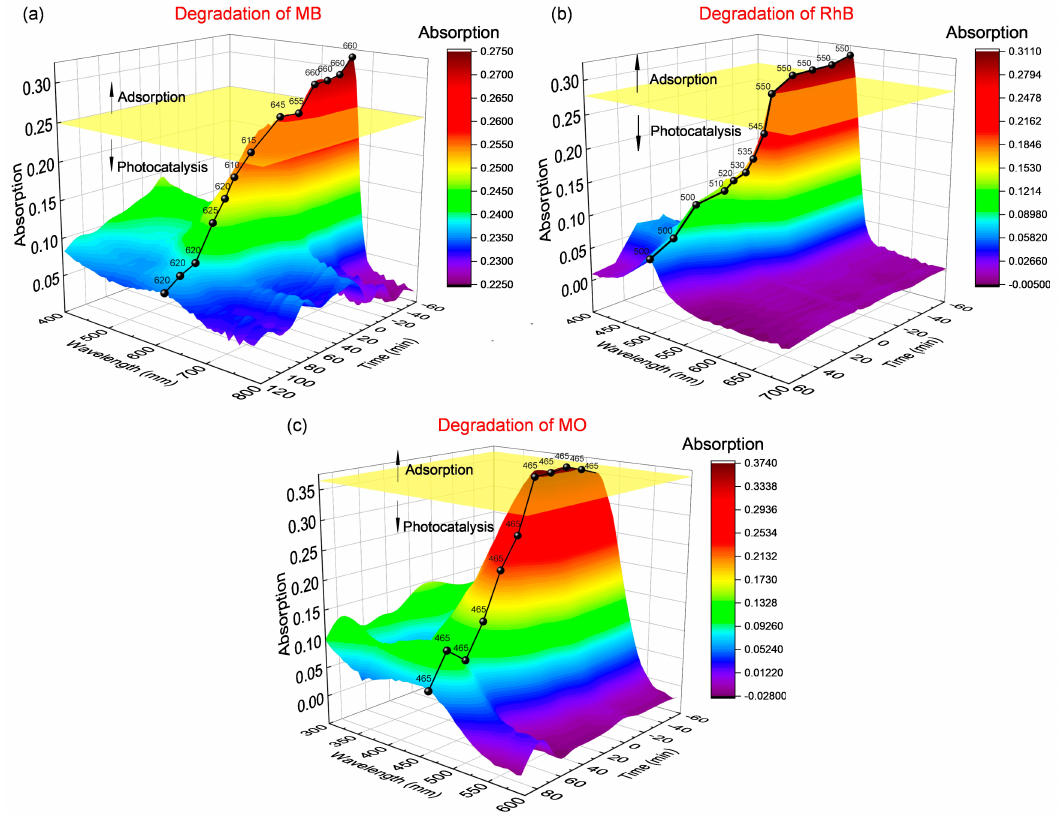
Figure 3. The absorption spectra of CdS NPs during MB ( a ), RhB ( b ), and MO ( c ) photocatalysis at different times (298 K, m CdS = 25 mg; [MB, RhB, and MO] = 10 mg L − 1 ; V = 100